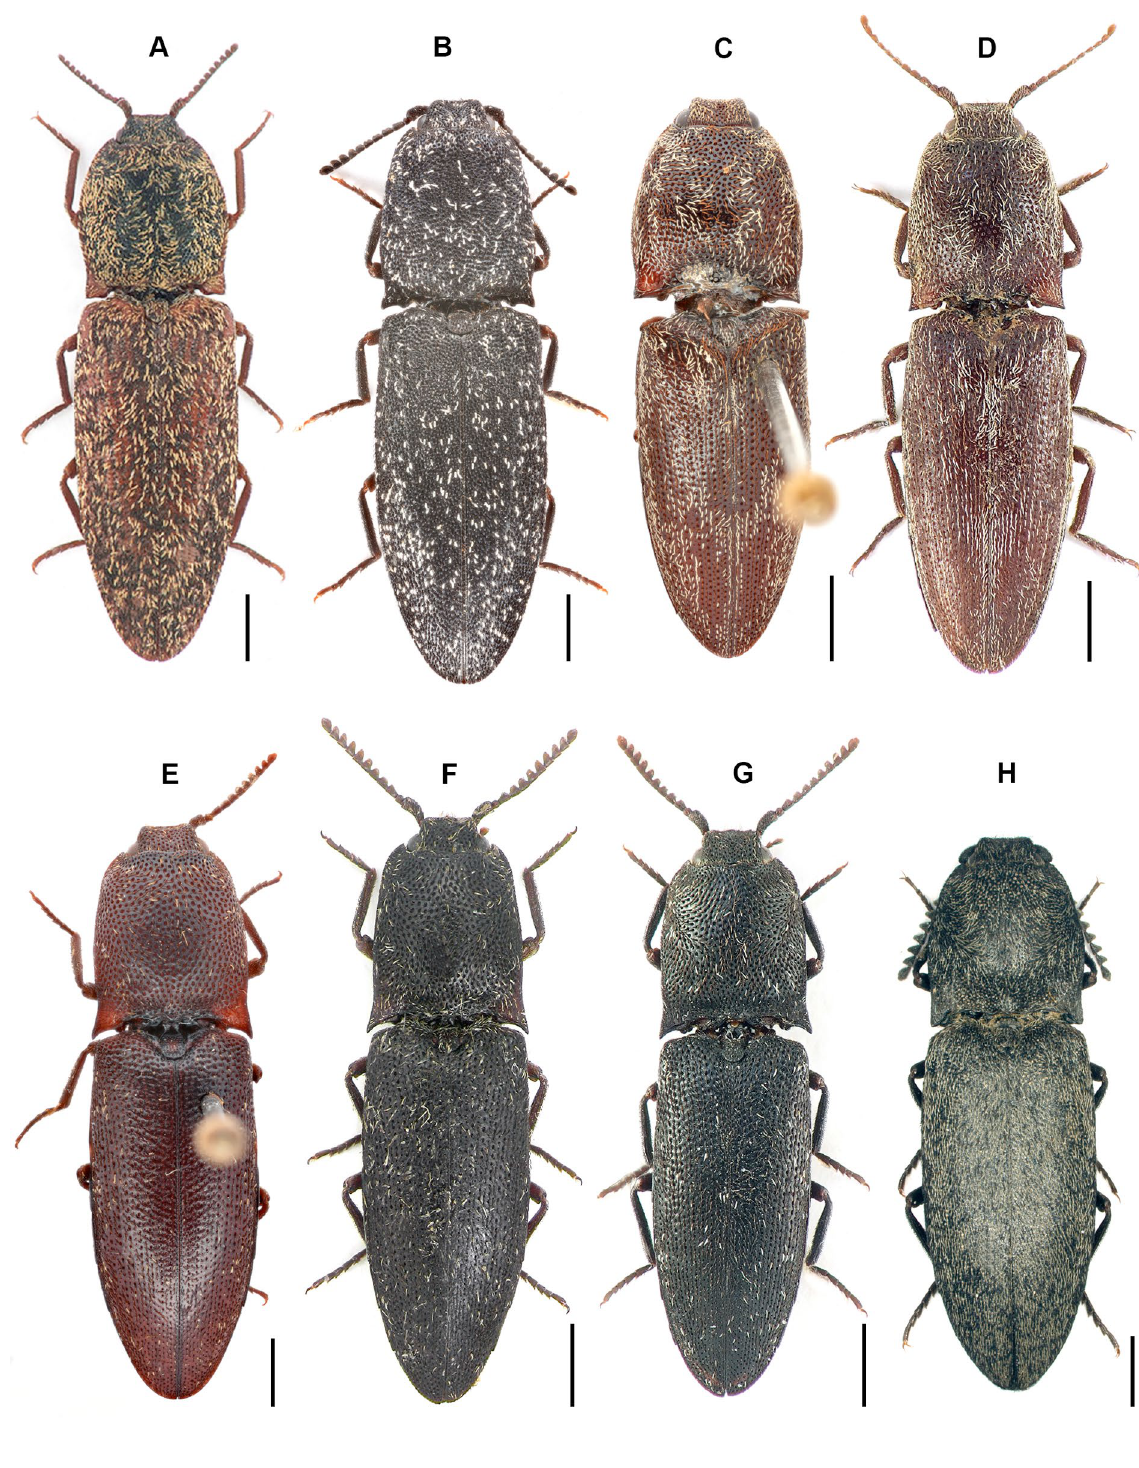
Fig. 4. habitus images of Lacon spp., dorsal view. A . L. lepidopterus (Panzer, 1801), ♀. B . L. punctatus (Herbst, 1779), ♀. C . L. modestus (Boisduval, 1835), lectotype, ♀. D . L. mekrani (Candèze, 1889), ♀. E . L. unicolor (Candèze, 1874), lectotype, ♀. F . L. unicolor , ♂. G . L. nadaii Platia & Németh, 2011, holotype, ♂. H . L. funebris (Solsky, 1881), ♂. Scale bars = 2.0